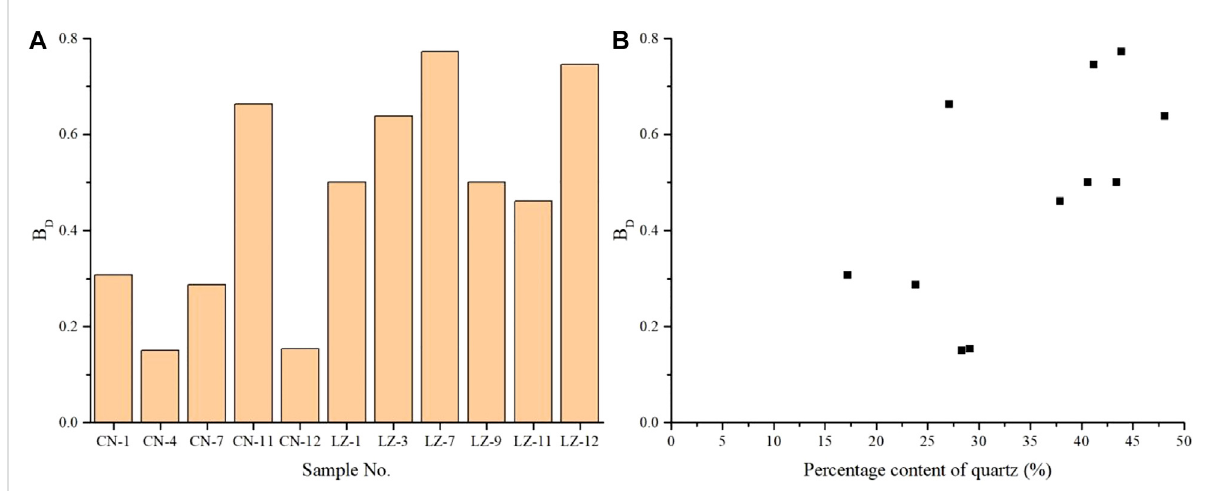
FIGURE 11 Distribution of the brittleness index of the Longmaxi Formation shale in the study area. (A) Brittleness index for different samples and (B) the relationship between the percentage content of quartz and brittleness